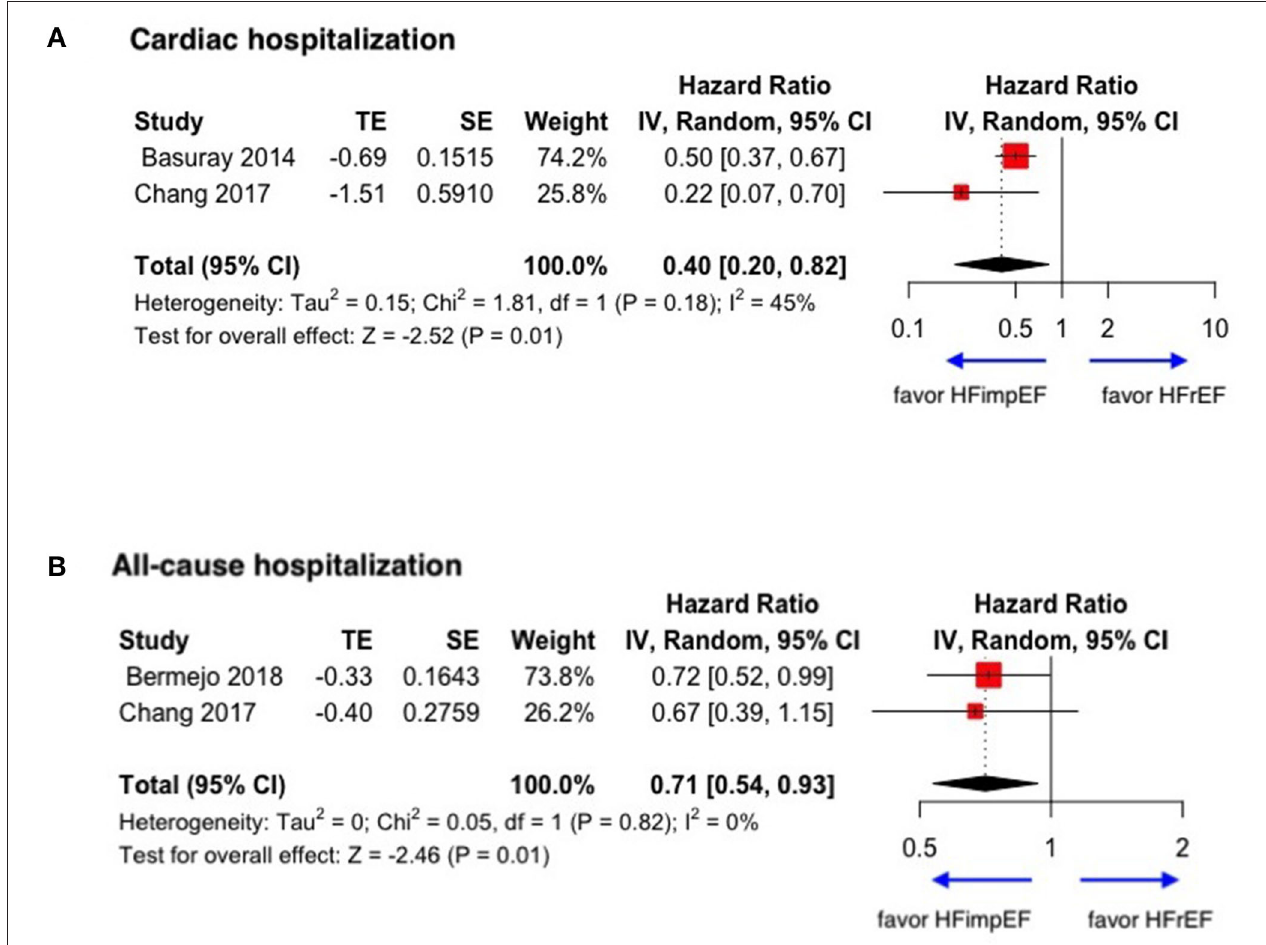
FIGURE 4 | Forest plots of cardiac hospitalization and all-cause hospitalization in patients between HFimpEF and HFrEF. (A) Cardiac hospitalization. (B) All-cause hospitalization.